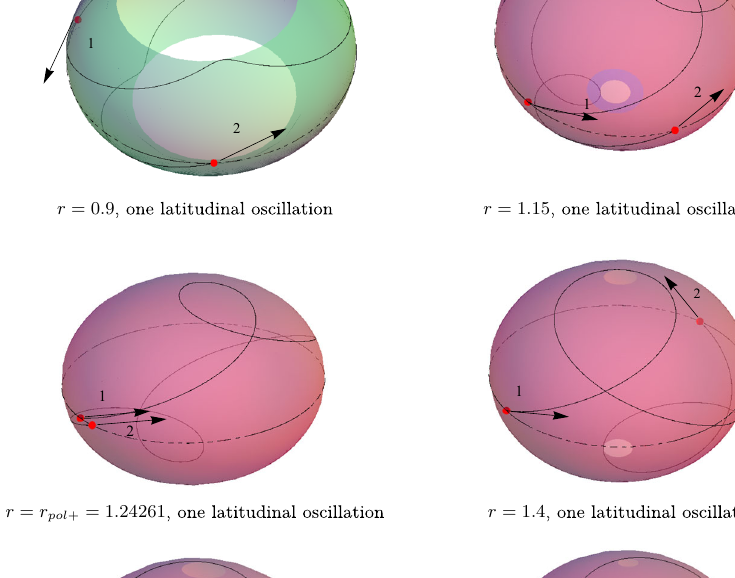
Fig. 20 Various types of the SPOs in the KNS spacetime with a = 1 . 1 . Stability/instability of the SPOs and their other characteristics are presented in the attached Table